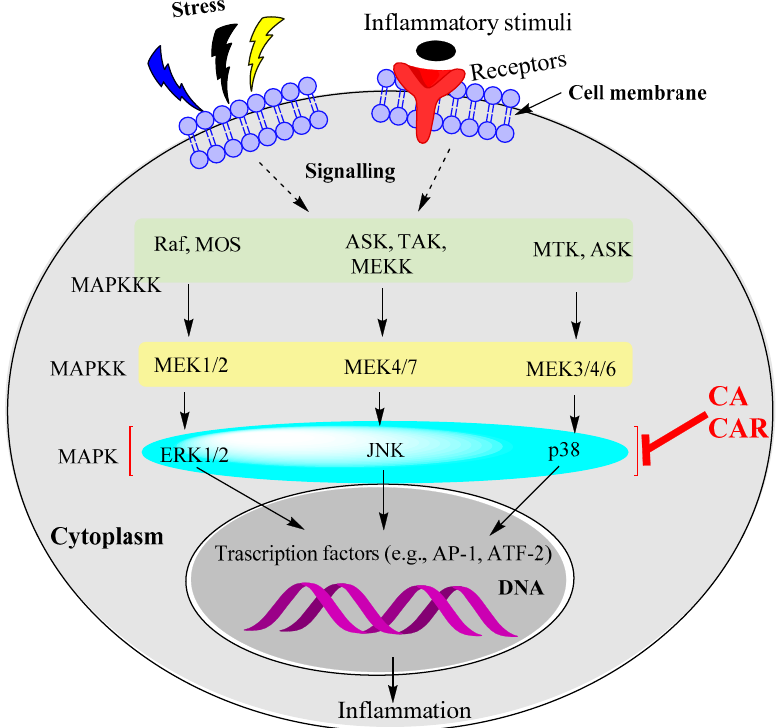
Figure 3. The MAPK pathways as targets for CA and CAR. The evidence available so far suggests that ERK1/2, JUNK and p38 MAPK phosphorylation are targeted by rosemary diterpenes to induce anti-inflammatory effects. Further research is required to determine whether the other kinases up- stream of MAPKs are affected by CA and CAR. At least one study shows that upstream kinases (TAK1) could also be affected.